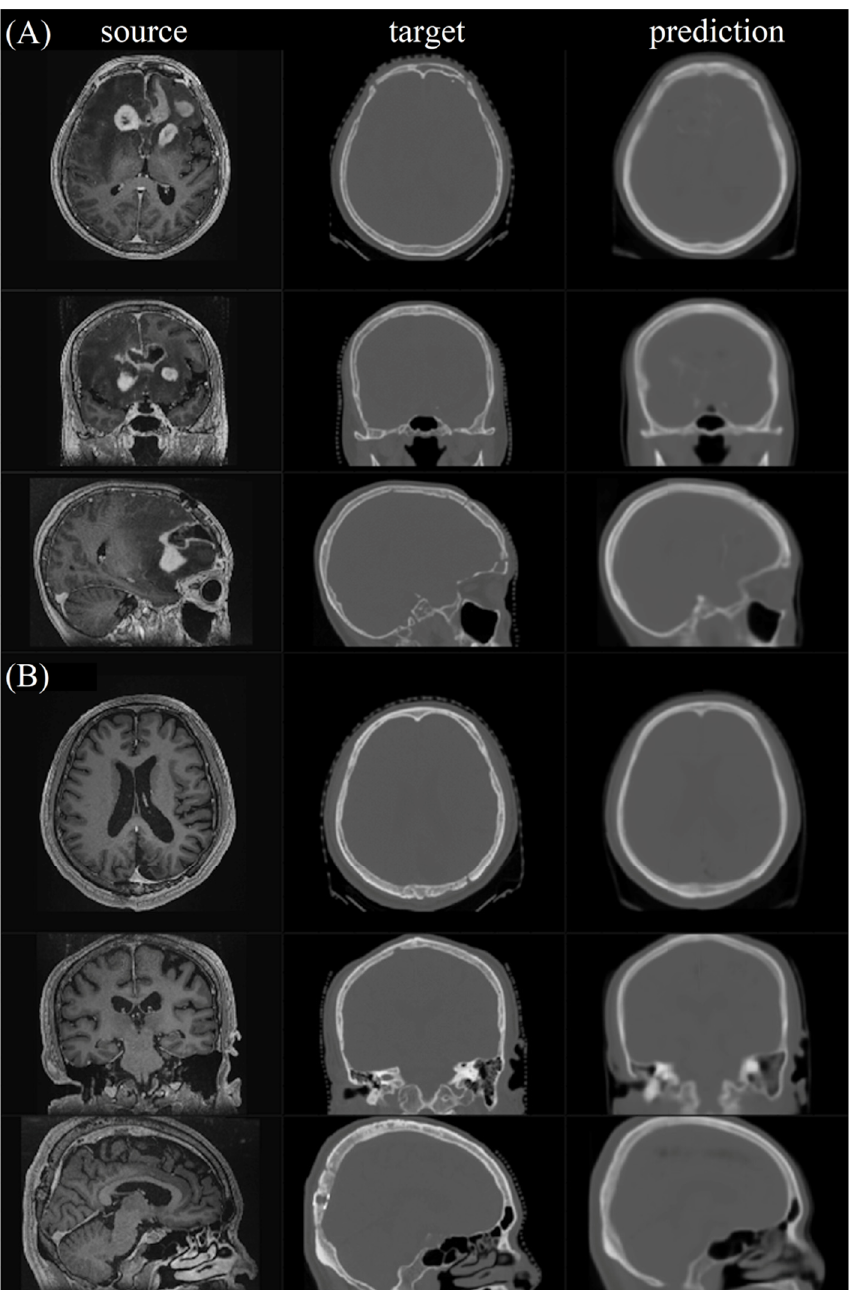
Figure 5. The final merged prediction. ( A ) and ( B ) show the two testing pairs, which are No. 001 and No. 003, and their corresponding merged predictions, respectively.